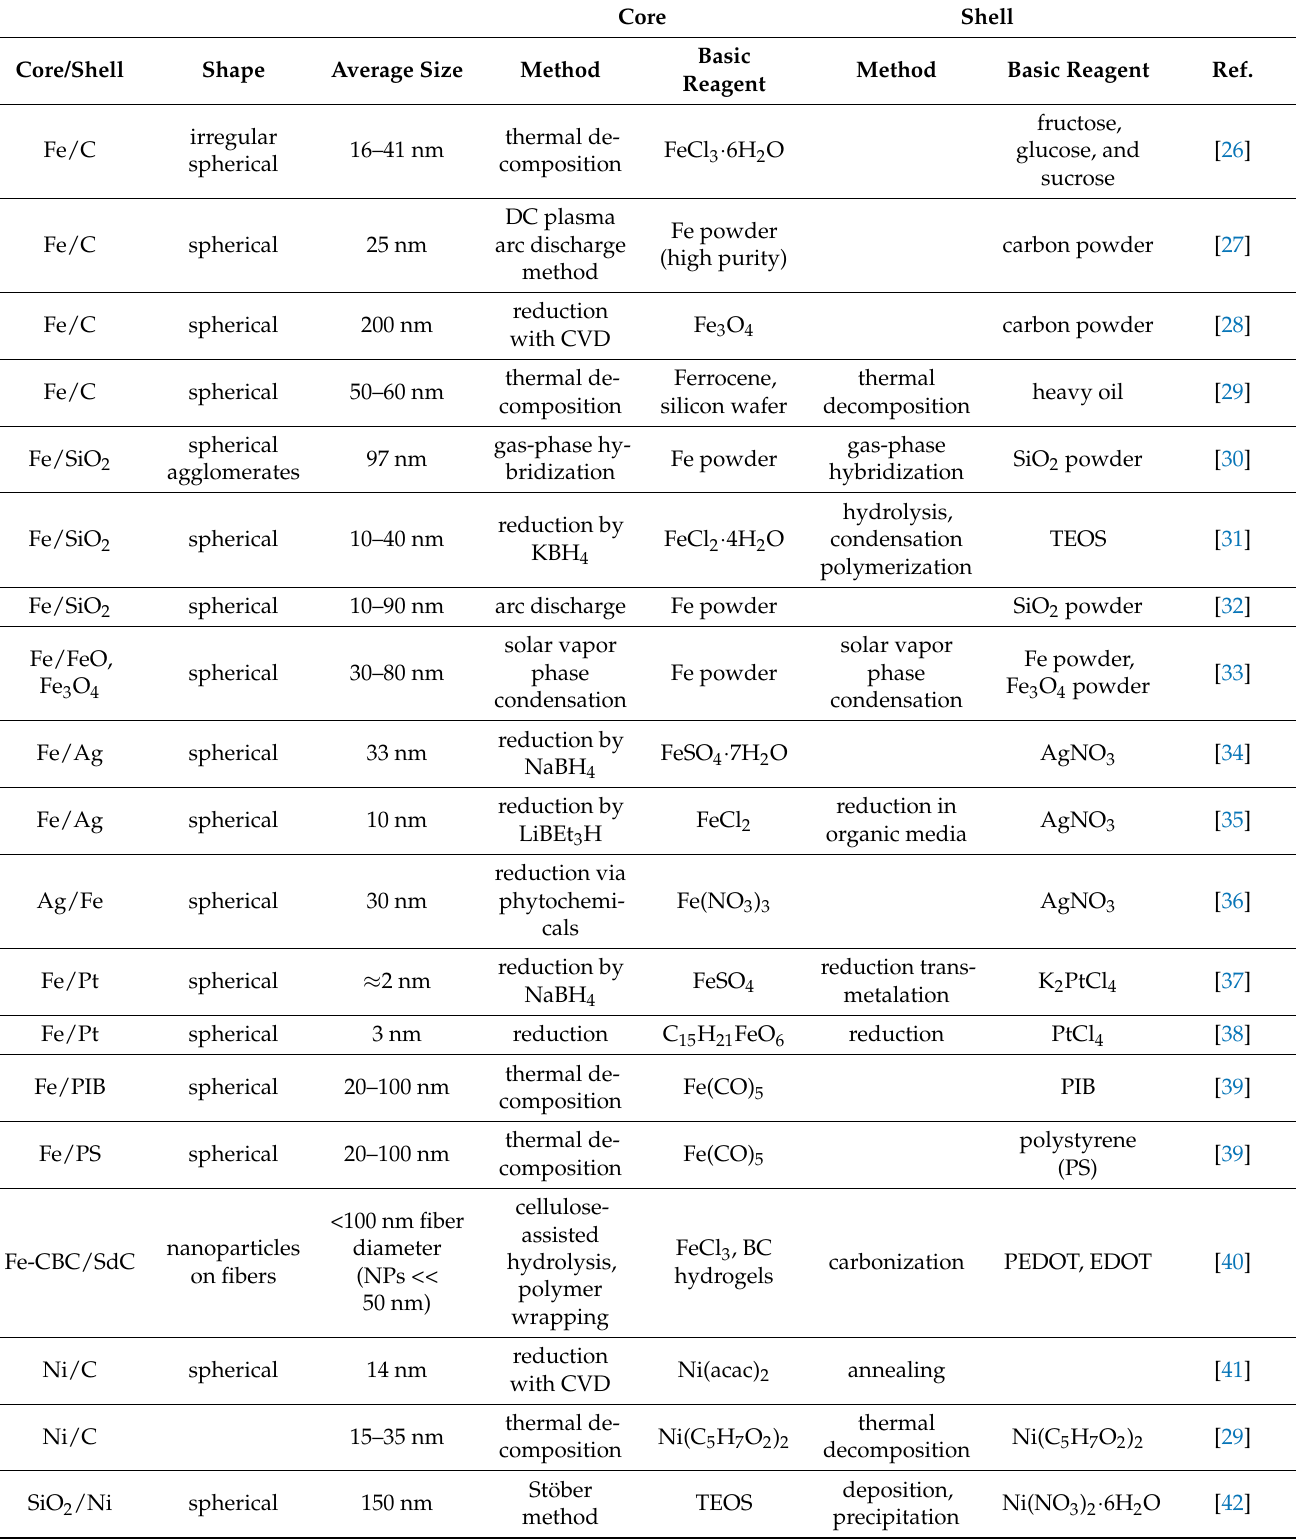
Table 1. Overview of production methods for magnetic core/shell